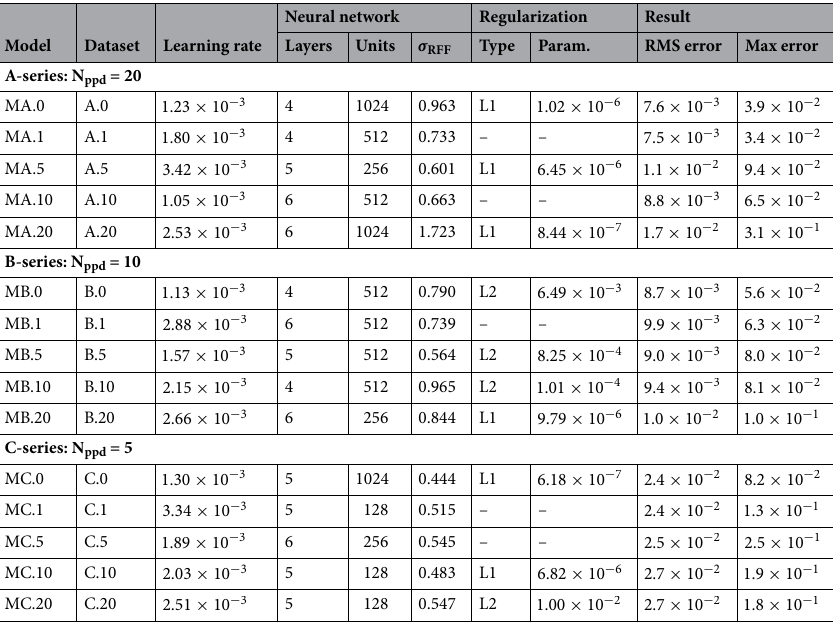
Table 3. Best models selection: from left to right the columns include the model’s name, the name of training set as listed in Table 2, the number of hidden layers and units, respectively, the σ RFF parameter for generation of Random Fourier Features embeddings, and final the RMS and Max statistics for the evaluation errors. The table is divided into three subtables, one for each density of sampling parameter, N ppd , characterising the training